Question: In one sentence, what is this figure communicating?
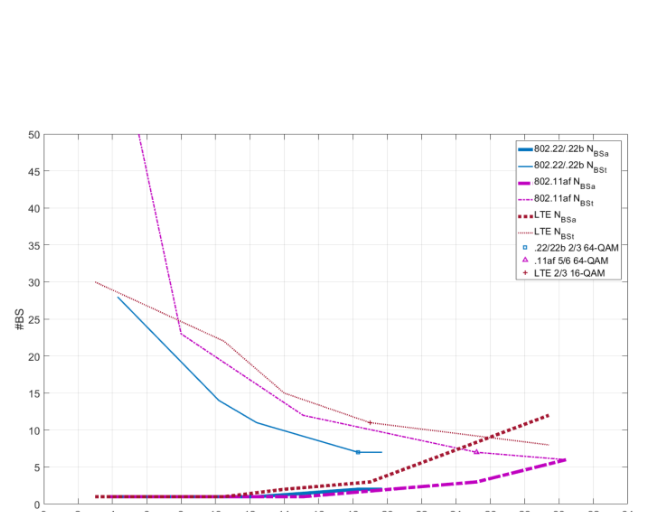
Answer: Minimum required number of BS vs required SNR in the rural  scenario.